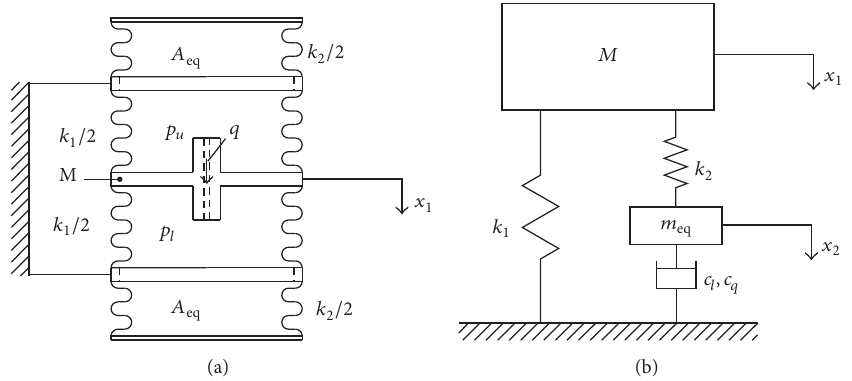
Figure 2: (a) Working schematic diagram of the isolator. (b) Equivalent system with two degrees of